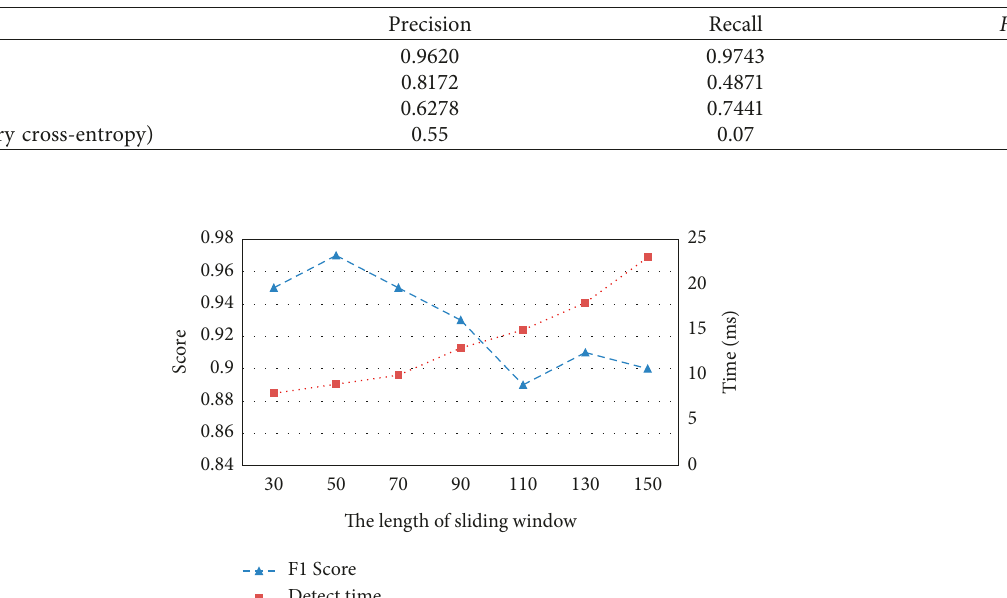
Figure 13: Sample reconstruction errors and thresholds. Table 2: Performance results of different methods.